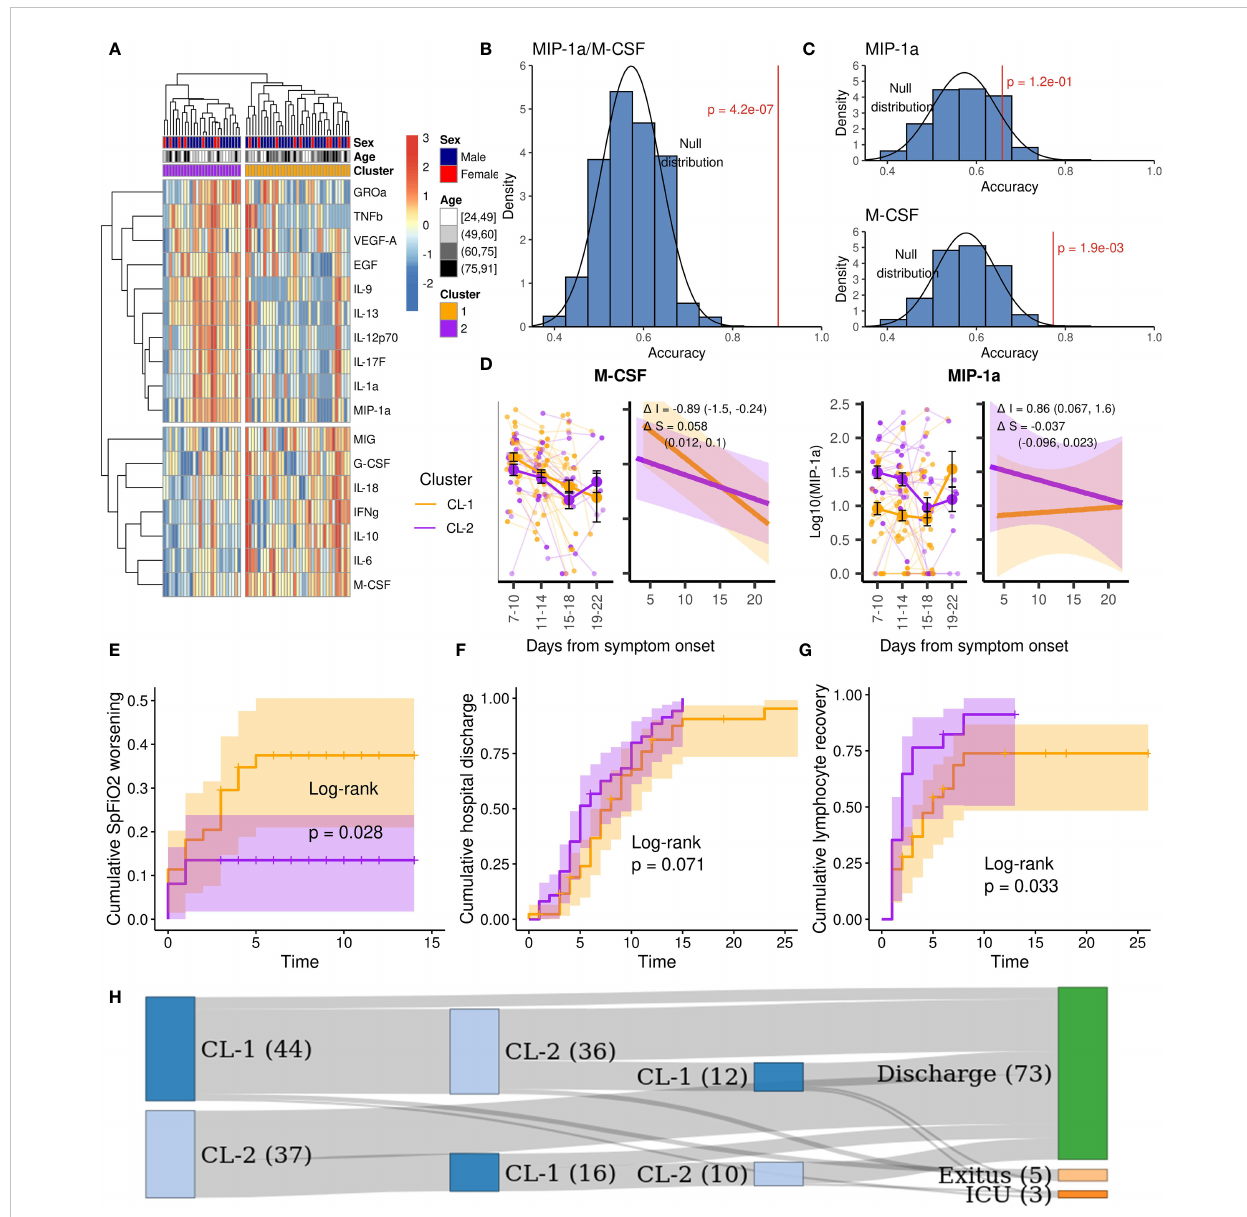
FIGURE 3 Cytokine clustering and patient ’ s outcome of the study population. Orange: Cluster 1; purple: cluster 2. (A) Clustered heatmap based on the 17 most variable cytokines. (B) Accuracy of the MIP-1 a /M-CSF ratio for the CL-2 prediction and the null distribution. (C) Accuracies of the MIP-1 a and M-CSF individually for the CL-2 prediction and the null distributions. (D) Expression over time of the most representative cytokines, right plots show the fi tted mixed linear models and their variation in fi xed intercept and slope effects between clusters. (E) Cumulative SpFiO and CL-2. (F) Cumulative hospital discharge for CL-1 and CL-2. (G) Cumulative lymphopenia recovery for CL-1 and CL-2. (H) Cluster progression before outcome (CL-1 is represented in dark blue and CL-2 in light